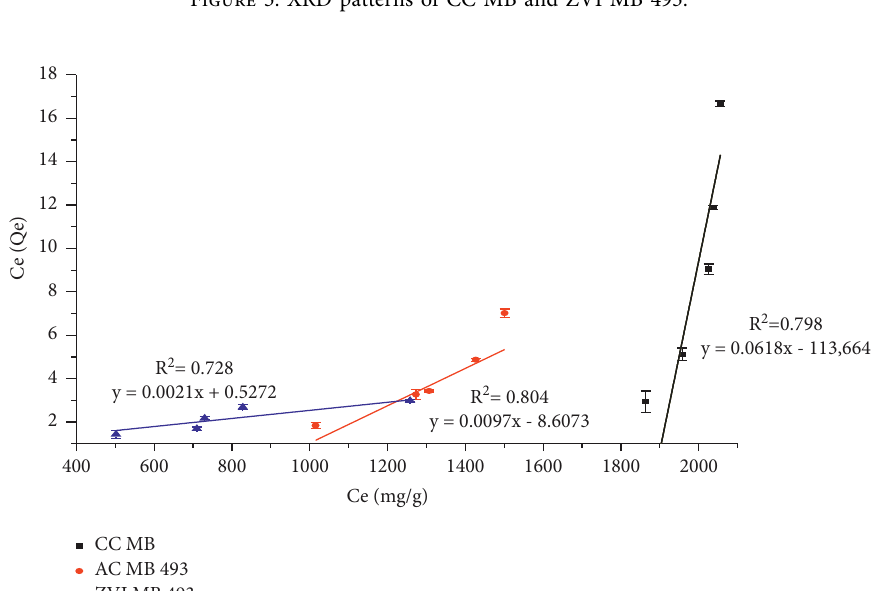
Figure 5: XRD patterns of CC MB and ZVI MB 493.